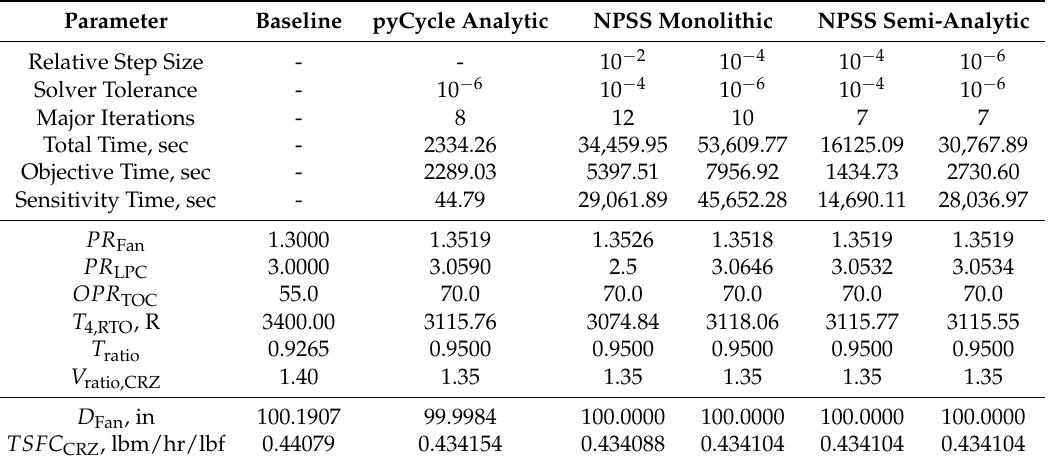
Table 7. Optimization results for the N + 3 reference